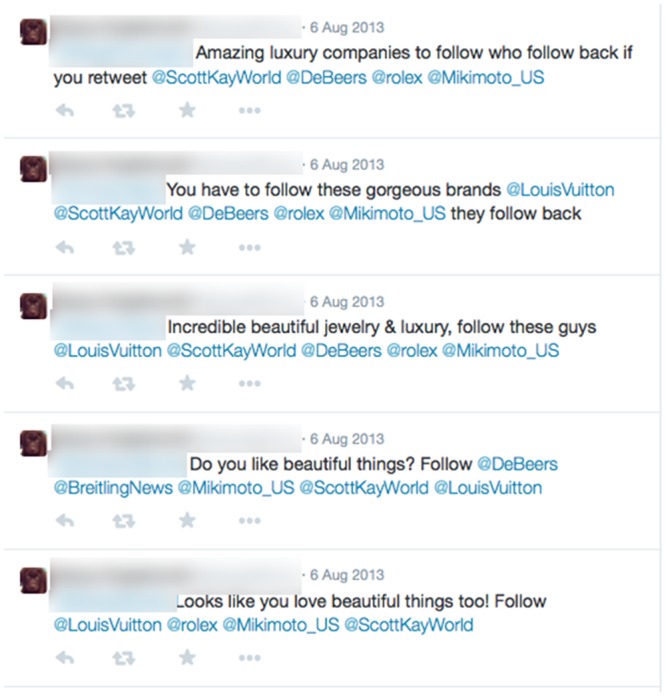
Example posts from one of the spam accounts we detected.